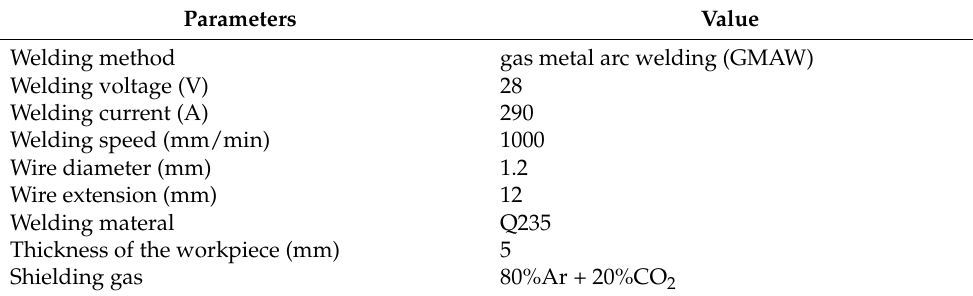
Table 1. Welding process